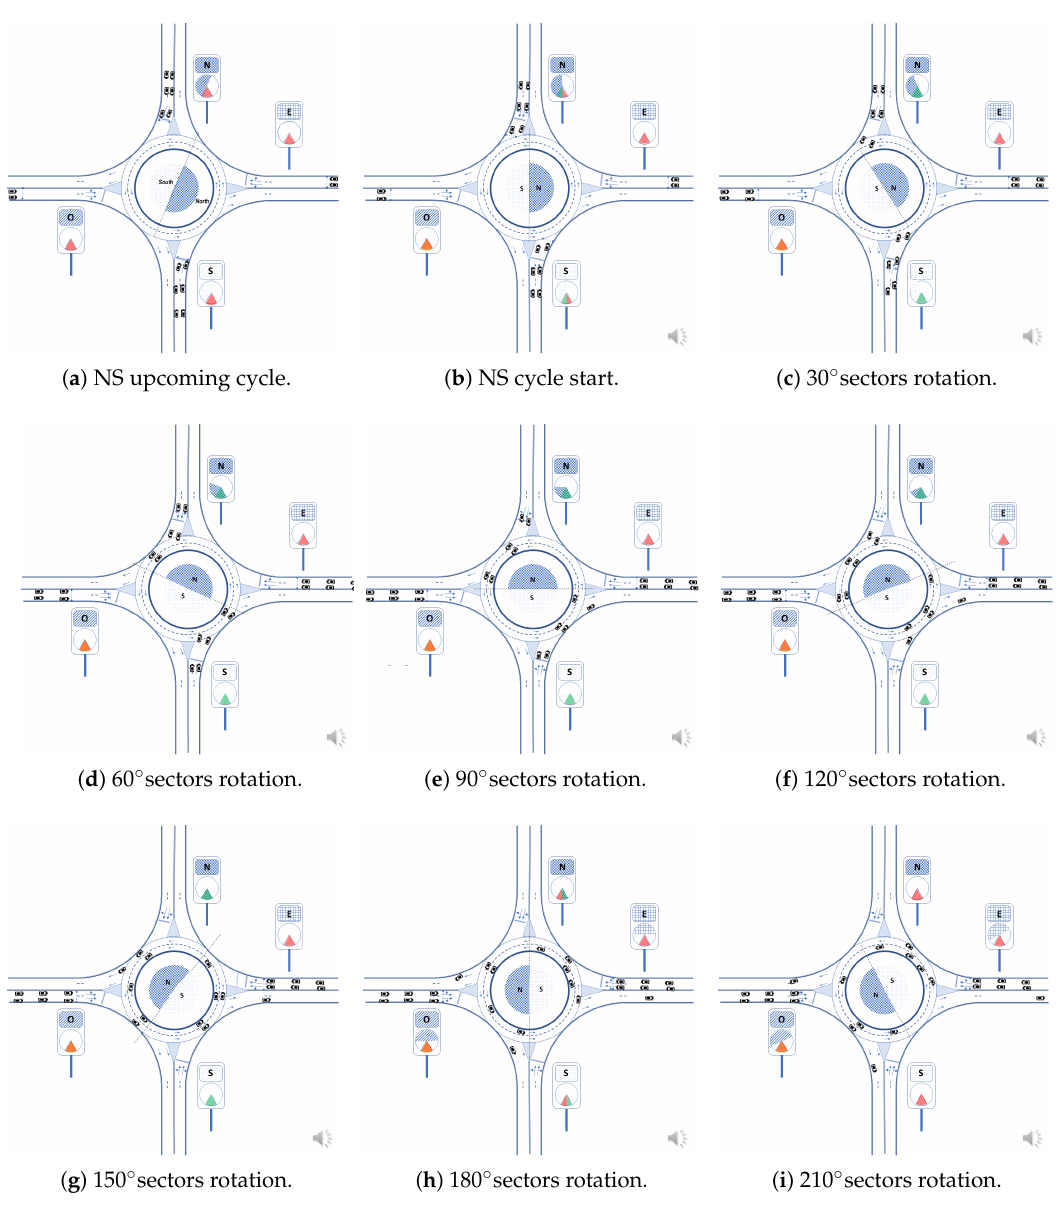
Figure 8. North-South (NS) access sequence. ( a ) shows the upcoming priority period for the north and south accesses. From ( b – h ), platoons at NS entries have priority. In ( i ) all entries are closed, and the roundabout